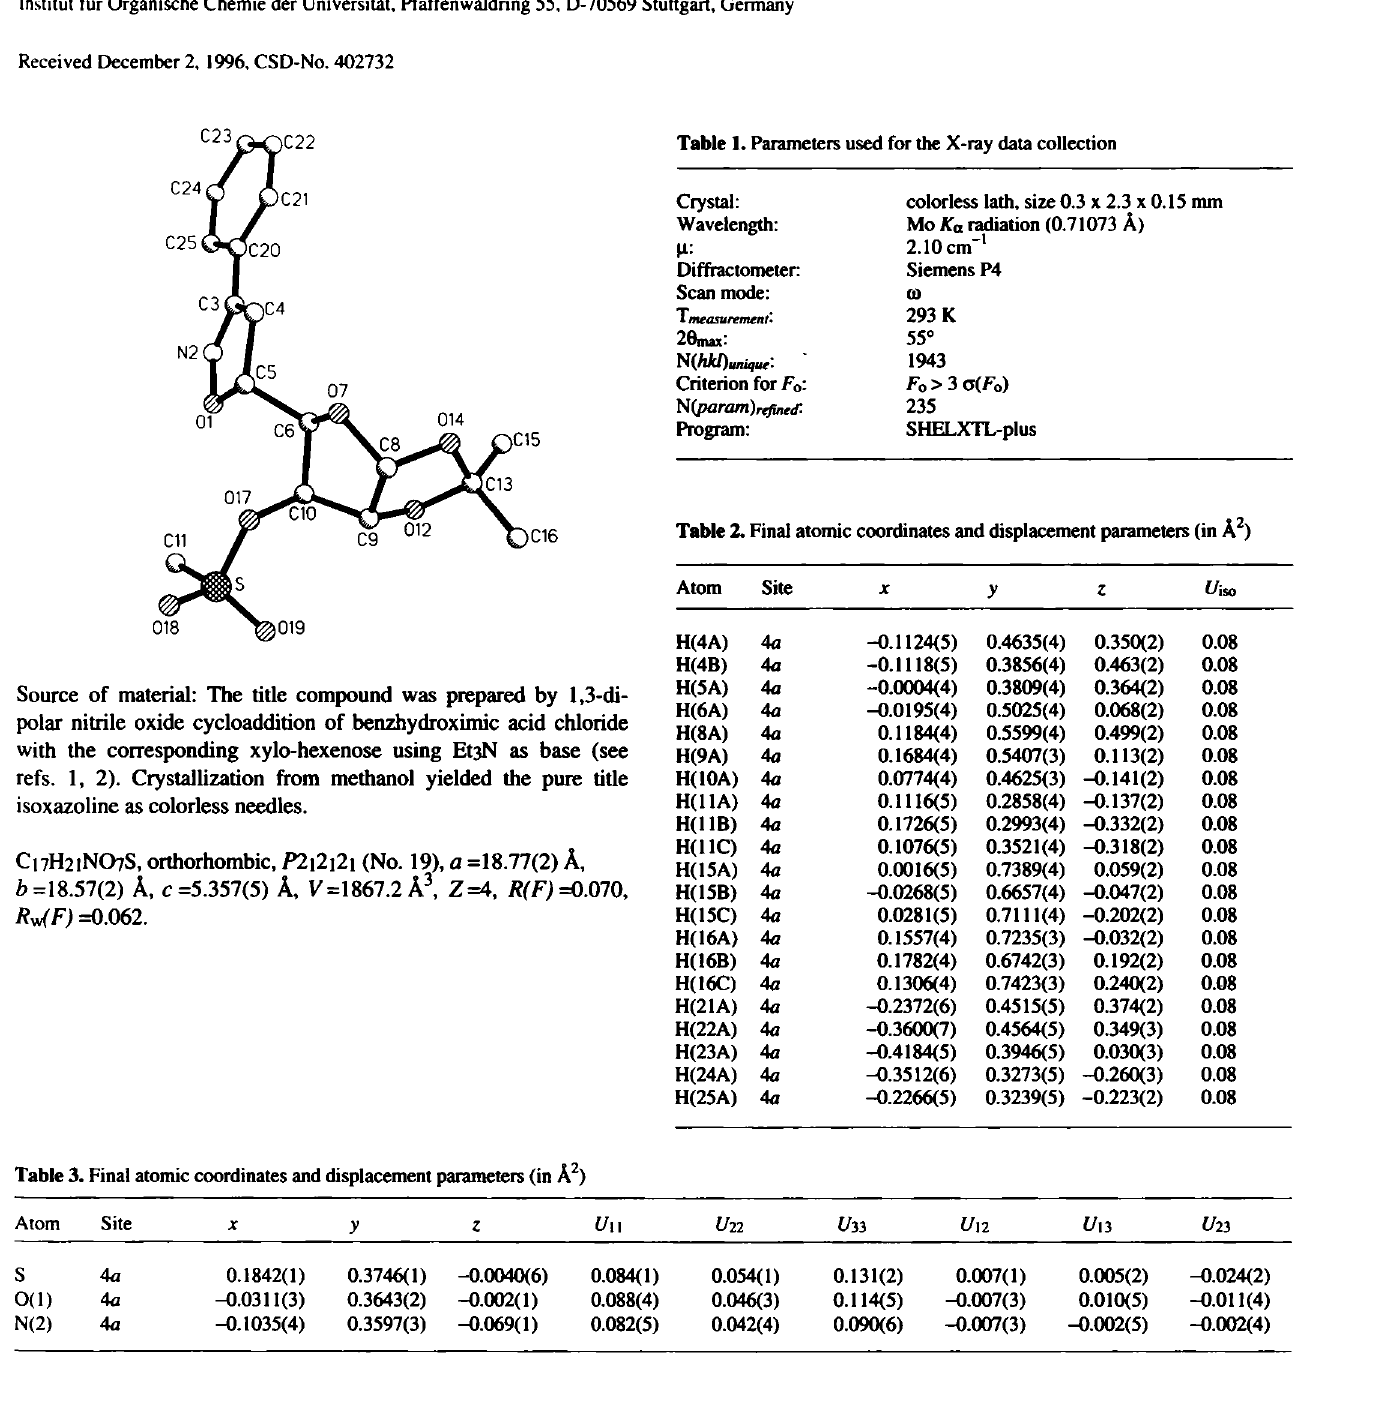
Table 1. Parameters used for the X-ray data collection